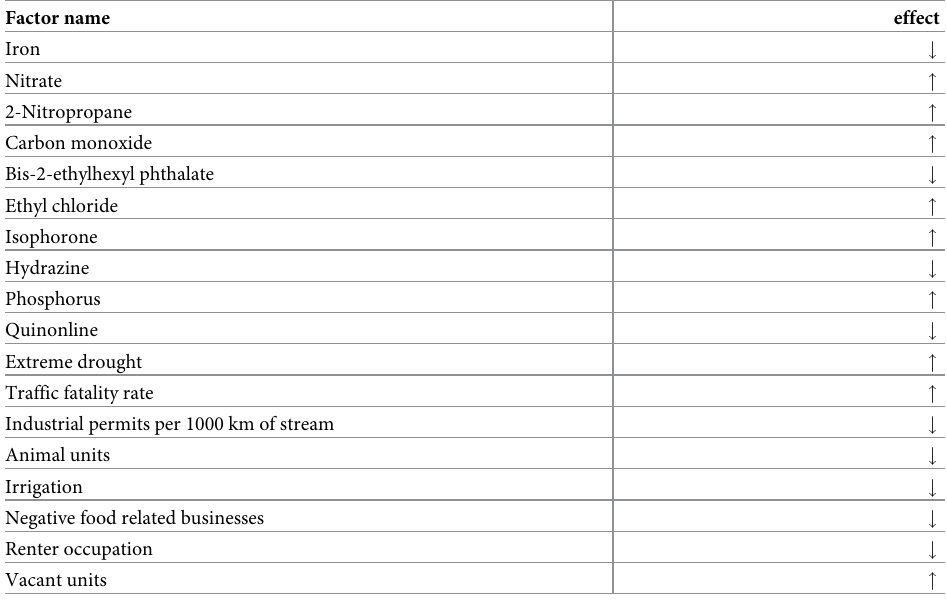
Table 4. Test results for additional factors with statistically significant effects. We included a factor only if both its Δ IC and the coefficient of at least one of its septiles was statistically